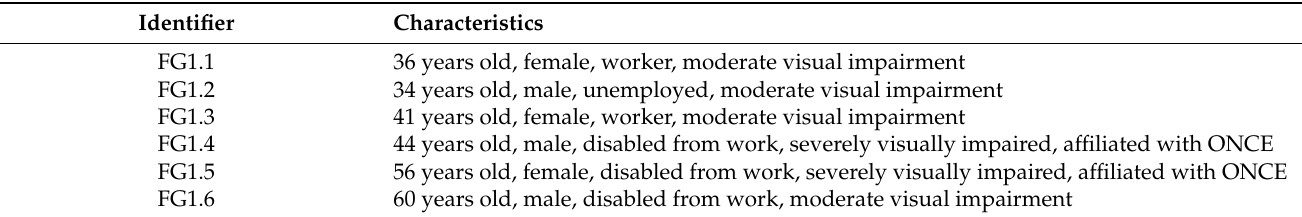
Table 1. Participants and characteristics of Focus Group 1.